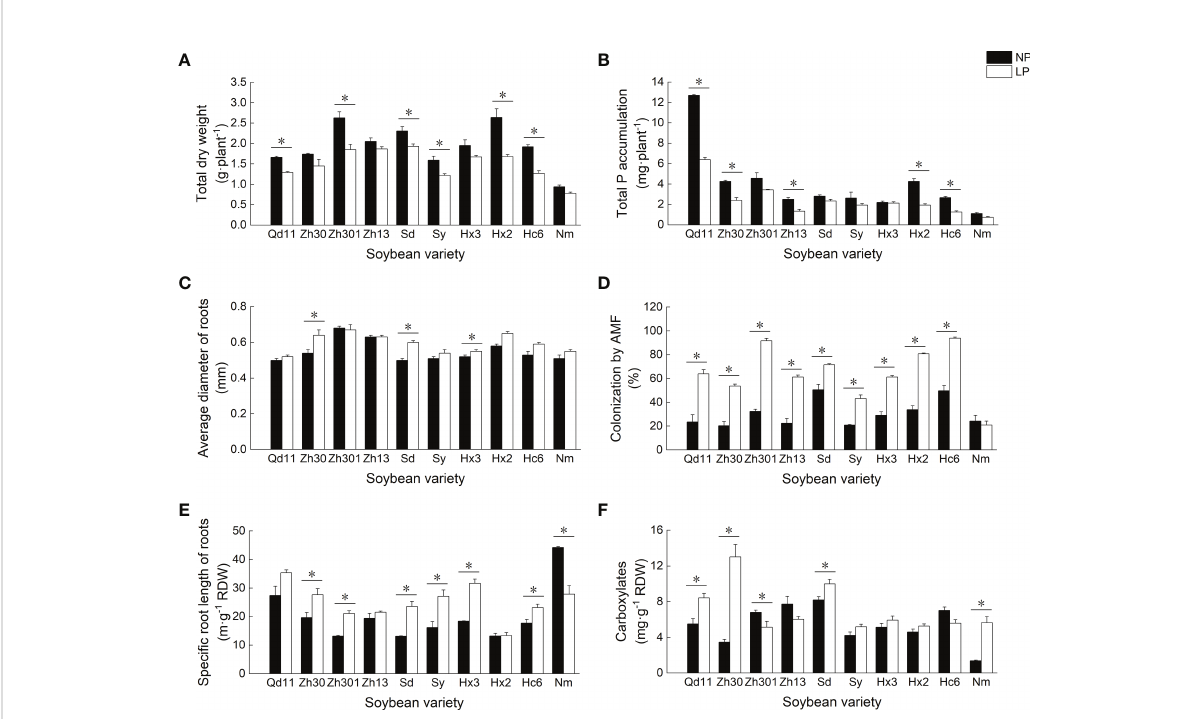
FIGURE 1 Effects of Pi availability among 10 varieties on the soybean physiology. Effects of Pi availability among 10 varieties on the (A) total dry weight; (B) total P accumulation; (C) average diameter of roots; (D) colonization by arbuscular mycorrhizal fungi; (E) speci fi c root length of roots; and (F) amounts of carboxylates in the rhizosheath. Varieties abbreviations: Qd11, Qian Dou 11; Zh13, Zhonghuang 13; Nm, Niu Mao Soybean; Sd, Shang Dou 1013; Qx1, Qixing 1; Hc6, Hua Chun 6; Zh30, Zhonghuang 30; Hx3, Hua Xia 3; Ax, Ai Xuan; Hx2, Hua Xia 2; Sy, Suiyang bean; Zh301, Zhonghuang 301; and Zh61, Zhonghuang 61. LP, low soil phosphorus availability; NP, normal soil phosphorus availability. *Denotes signi fi cant difference between P treatments (based on LSD, p ≤